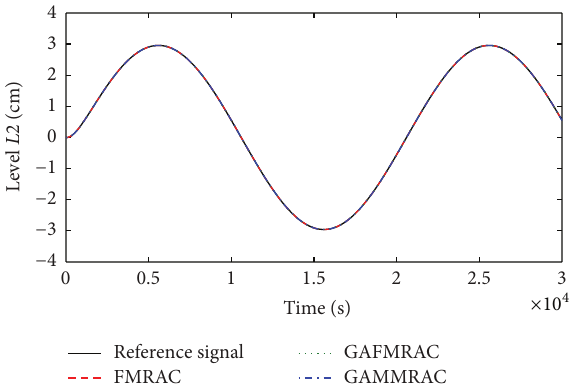
Figure 11: Response of the three controllers to a sinusoidal com- mand signal when 𝐺 𝑀2 (𝑠) is used as the reference model.